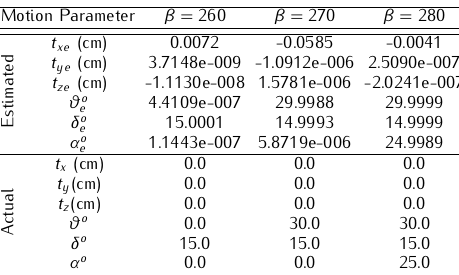
Comaprisons of estimated and actual motion parameters (Rotational Motion corrupted case).